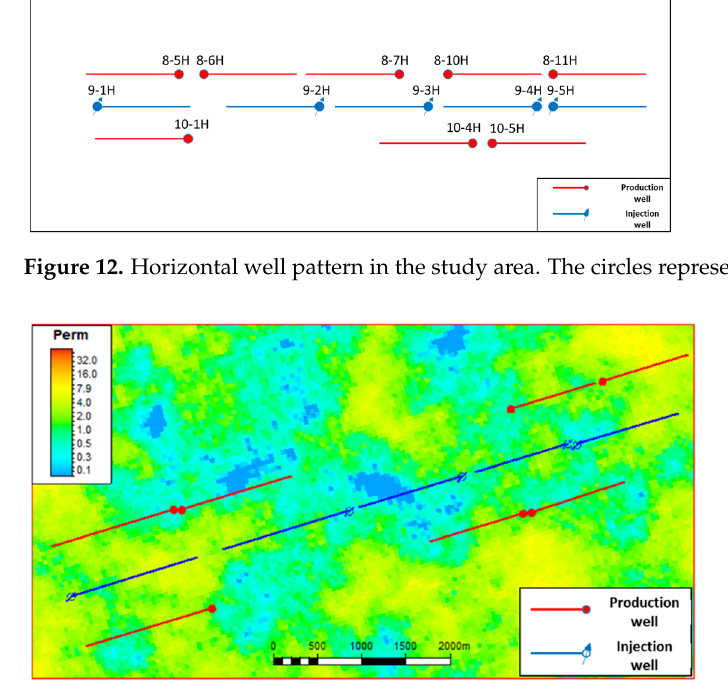
Figure 13. Permeability distribution map of injection - production area in a horizontal well. The circles represent wellhead positions. Table 2. Table of injection-production relationship of horizontal well